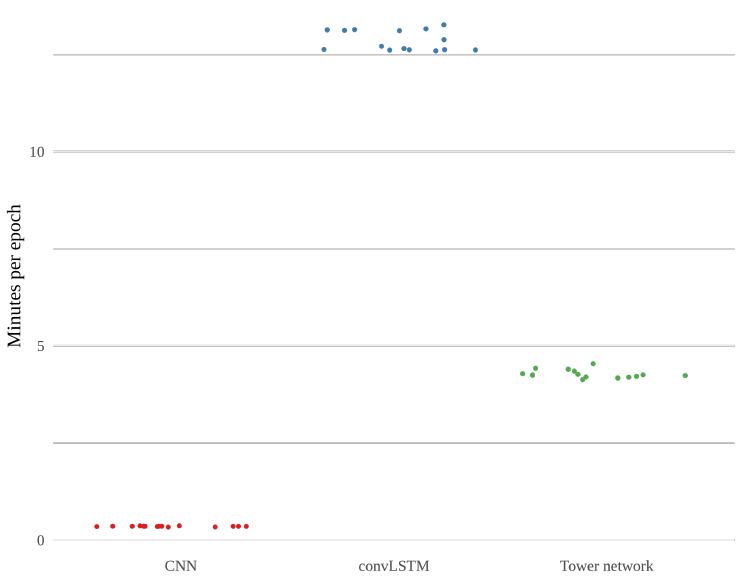
Figure 10. Training time per epoch for the 15 realizations of CNN, convLSTM and tower network in